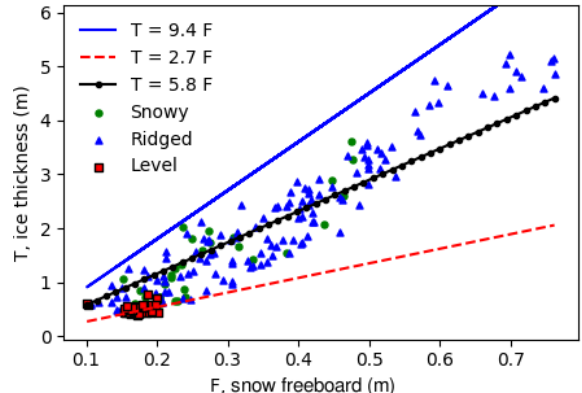
Figure 10. The SIT ( T ) as a function of measured snow freeboard ( F ). As expected, all points lie between the two extreme regimes (no ice freeboard and no snow freeboard). The level surfaces mostly have no ice freeboard, as expected, though there is some scatter that suggests a varying component of ice freeboard. The best-fit line for all windows from Table 3 is shown in black. Assuming mean snow and ice densities of 300 and 920kgm − 3 , this implies a mean proportion of 55% snow and 45% ice in the snow free- board. Again, the scatter around the best-fit line indicates that this proportion is changing. Some points for the level category fall be- low the T = 2 . 7 F line, suggesting that snow densities in these areas are < 300kgm − 3 (or effective ice density < 915kgm − 3